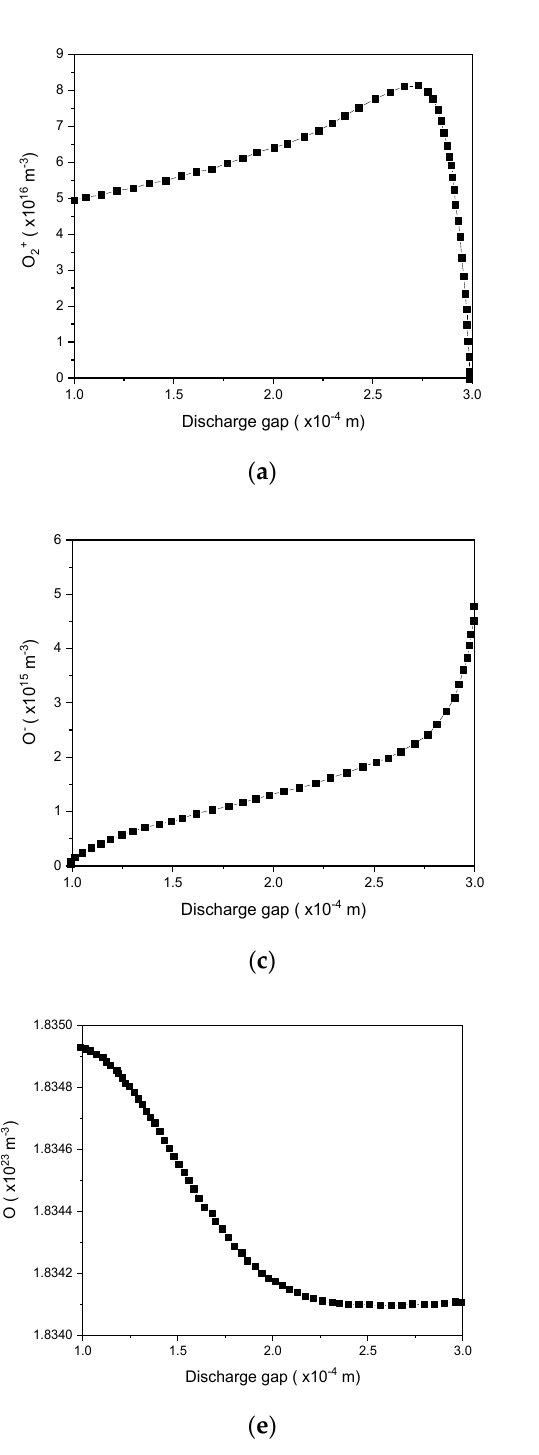
Figure 8. Density distribution of O 2+ ( a ), O + ( b ), O 2 ( c ), O − ( d ), and O ( e ) in the gap at the maximum discharge current.